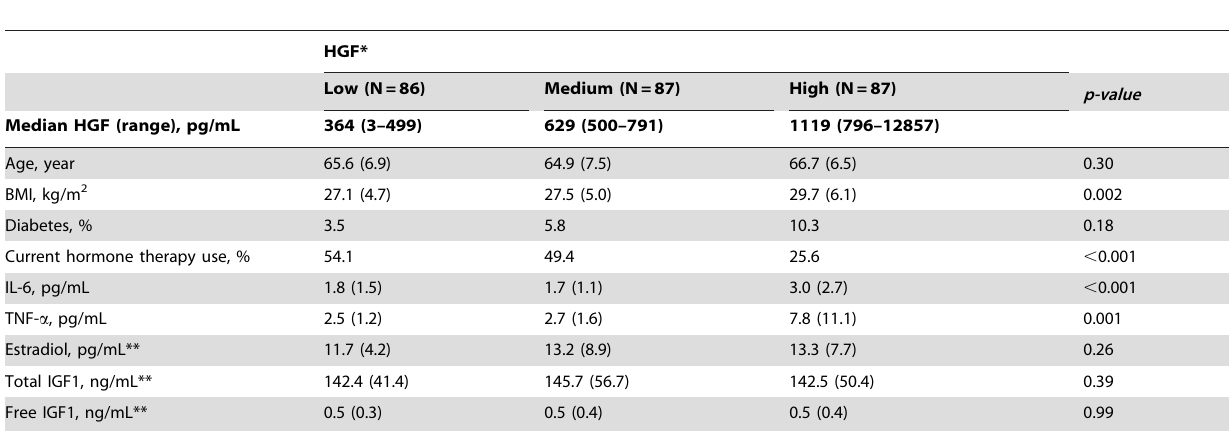
Table 1. Selected characteristics (mean 6 standard deviation or %) among women from the Women’s Health Initiative Observational Cohort Study (WHI-OS) according to plasma levels of hepatocyte growth factor